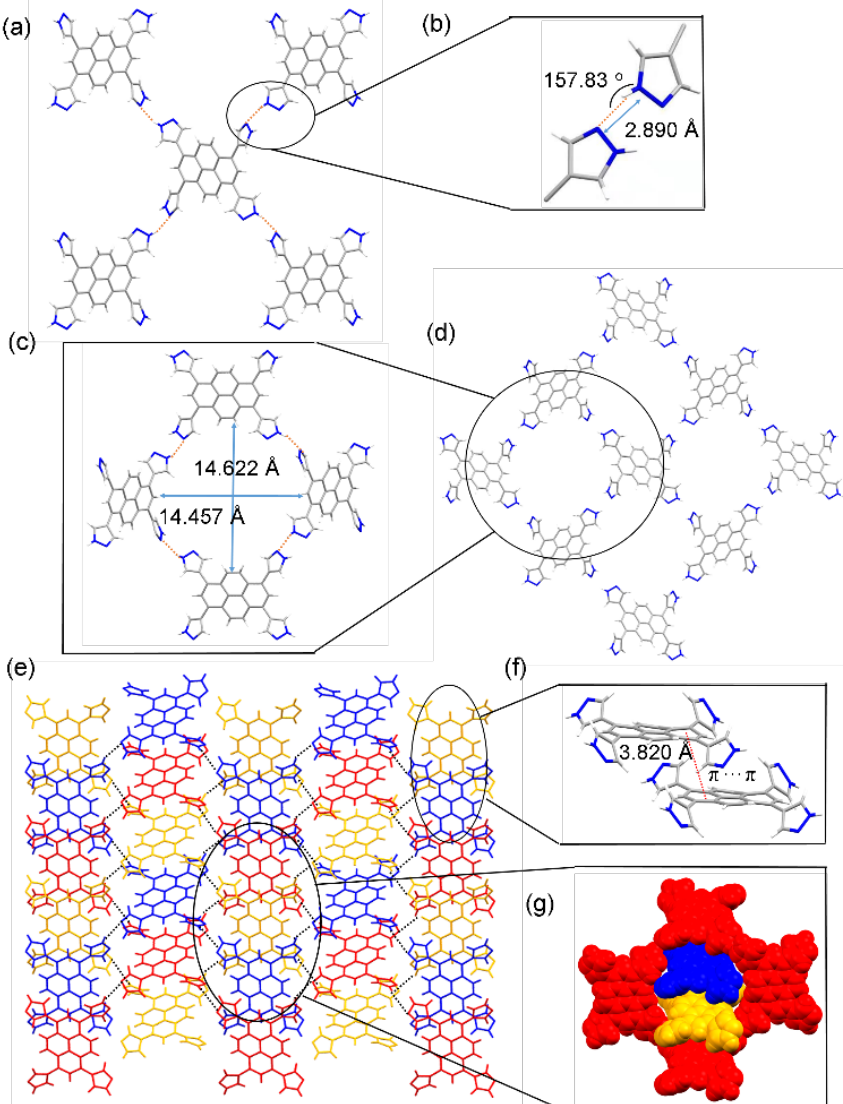
Figure 3. Crystal structures of HOF-1 . ( a ) View of the structure and the connection of adjacent building blocks. ( b ) Hydrogen-bond length and angle. ( c ) π···π interactions. ( d ) One-dimensional (1D) channels. ( e ) Representation of the porous framework. ( f ) π···π interactions. ( g ) One-dimensional (1D) channels.